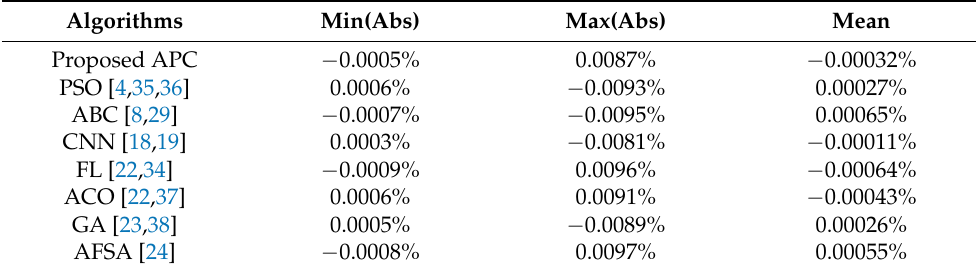
Table 4. Node positioning data statistics on the iterative error (200 sensor nodes, communication range r = 20 m, 20% anchor nodes, population size m =